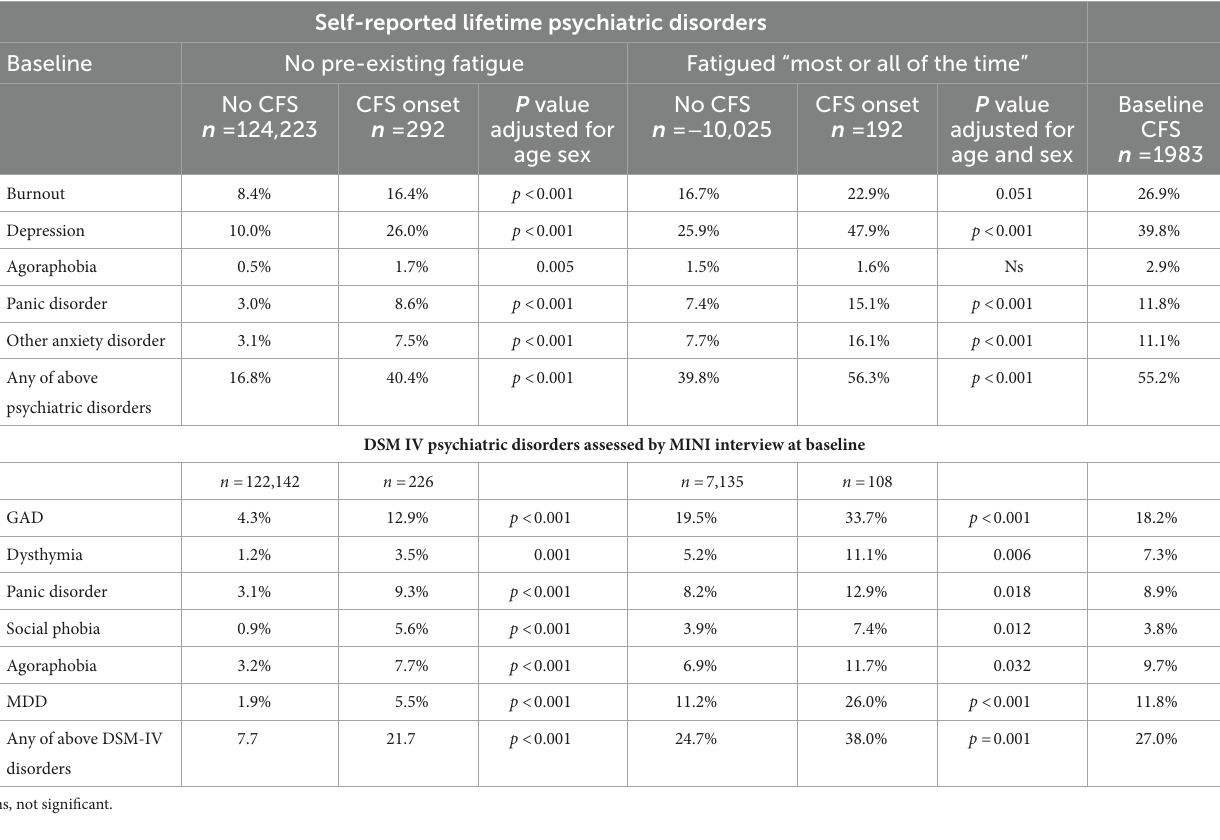
TABLE 4 Psychiatric disorders and self-rated chronic fatigue syndrome onset by baseline fatigue.